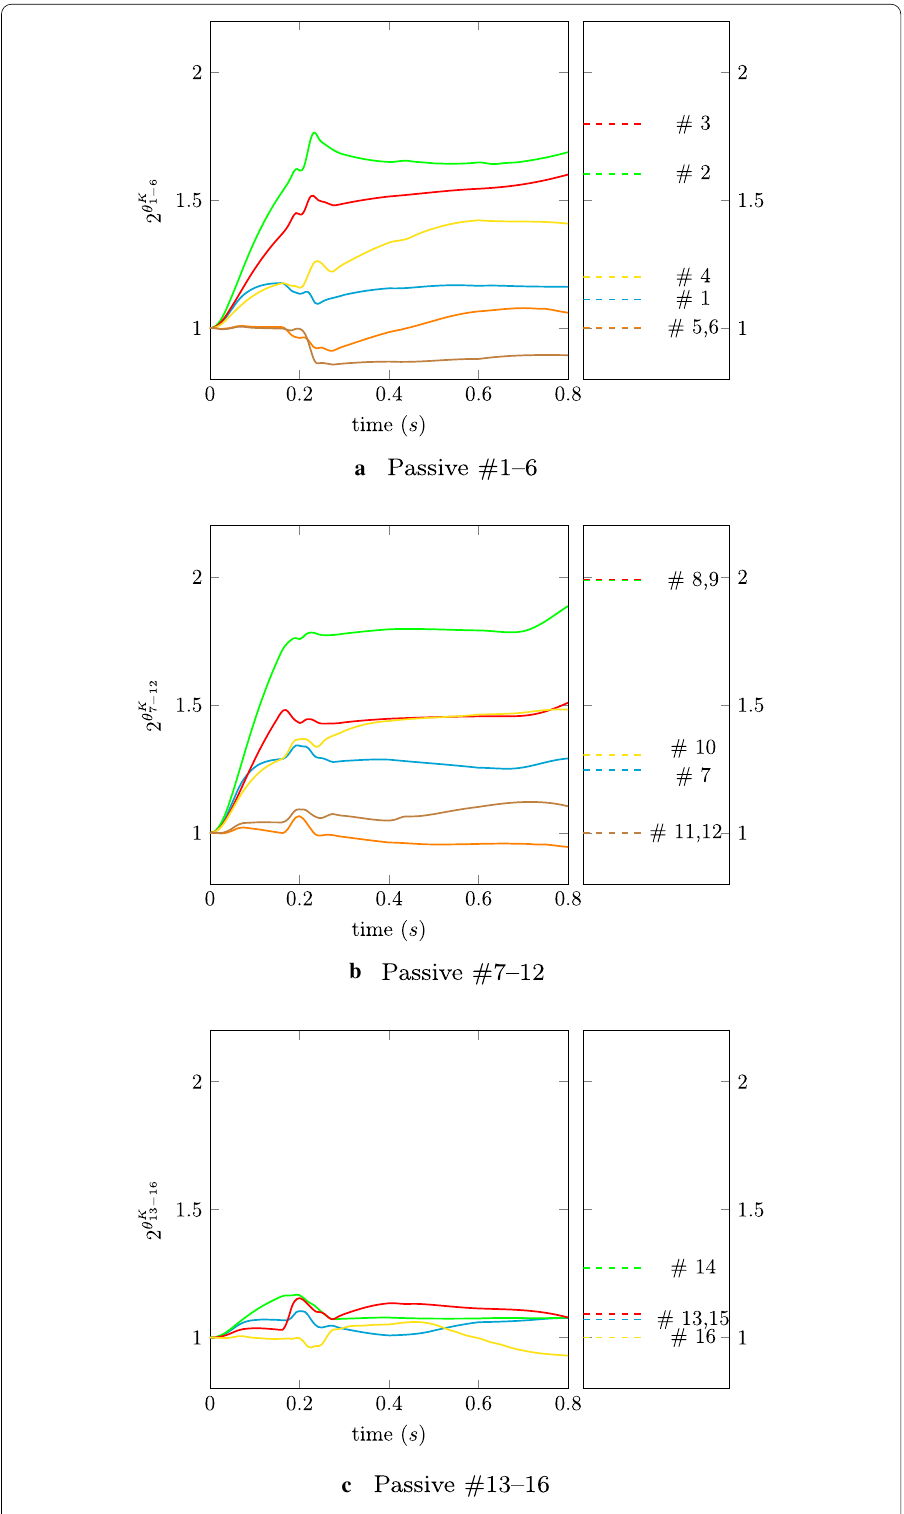
Fig. 18 Time evolution of and passive estimated parameters using tag planes with coarse time sampling of the observations (dashed lines give reference